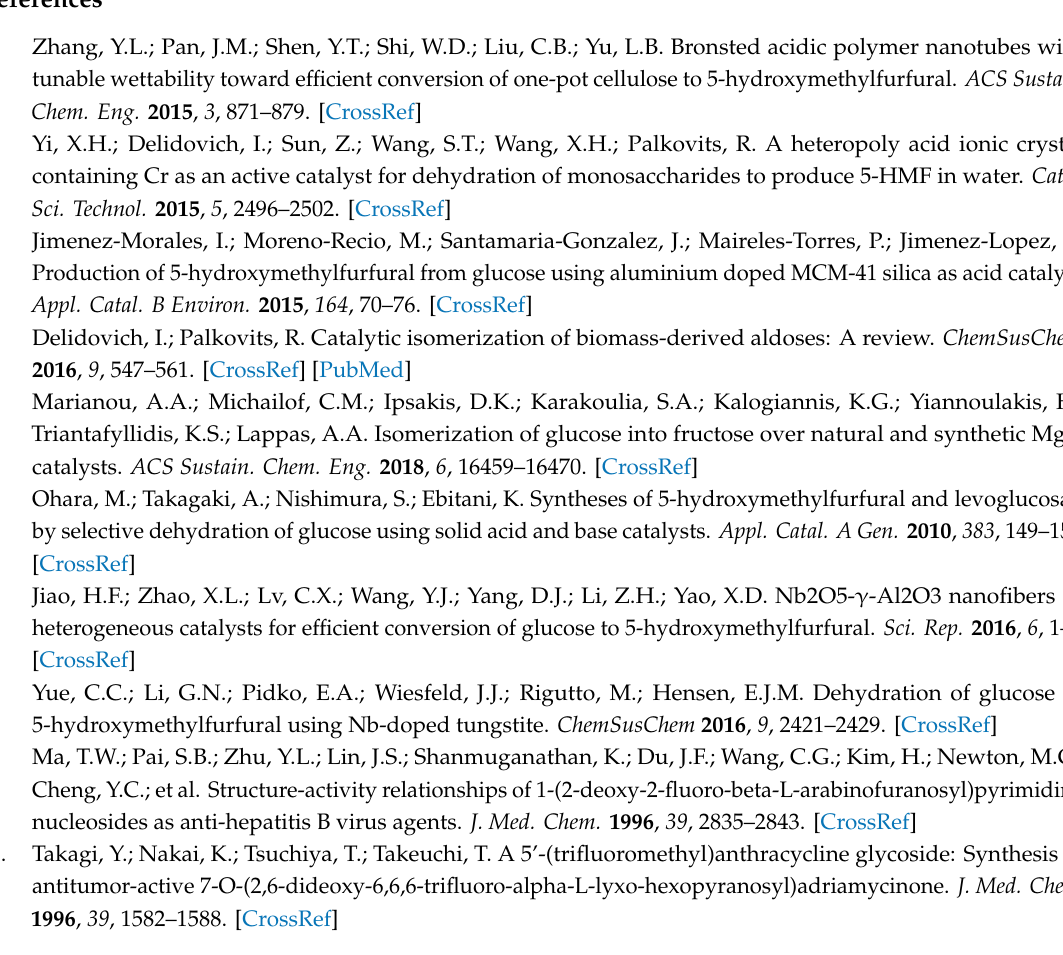
Figure S1. N 2 adsorption-desorption isotherms of (a) SBA-15, (b) NH 2 -SBA-15, (c) 3.3PMo / NH 2 -SBA-15, (d) 6.7PMo / NH 2 -SBA-15, (e) 10PMo / NH 2 -SBA-15, (f) 13.3PMo / NH 2 -SBA-15, and (g) 16.7PMo / NH 2 -SBA-15, Table S1: Catalytic performance of 13.3PMo / NH 2 -SBA-15 for glucose